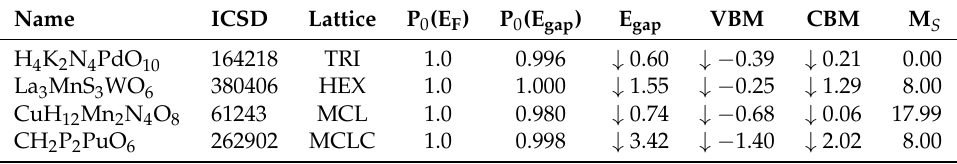
Table A4. Quinary half-metallic oxides. Parameters are the same as in Table